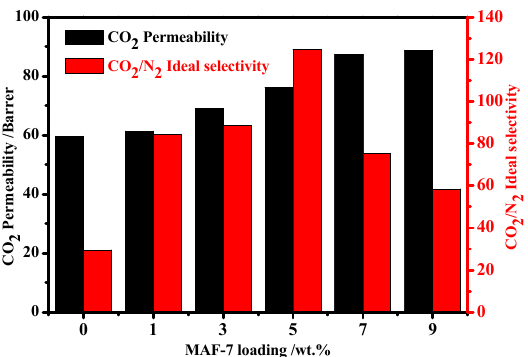
Figure 8. CO 2 permeability and CO 2 /N 2 ideal selectivity as a function of different filler loadings.